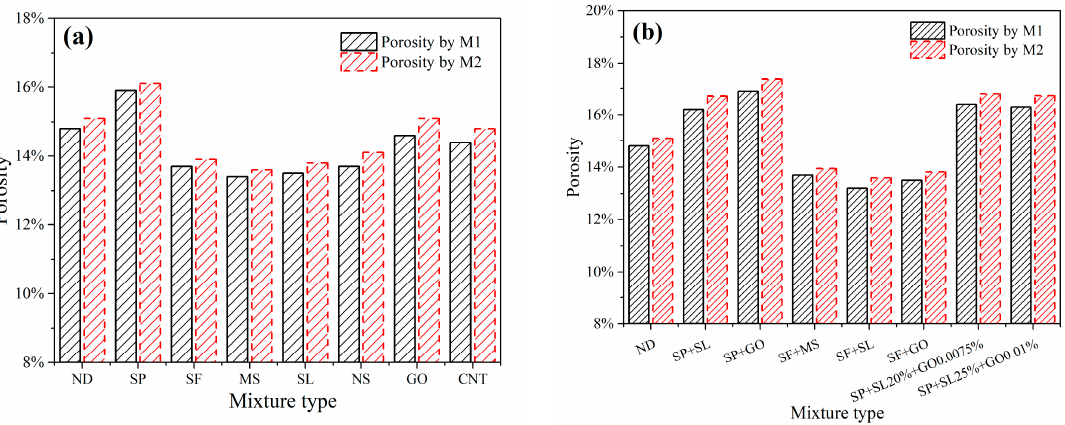
Figure 5. Comparison of porosity obtained by two methods: ( a ) single admixtures; ( b ) composite admixtures.